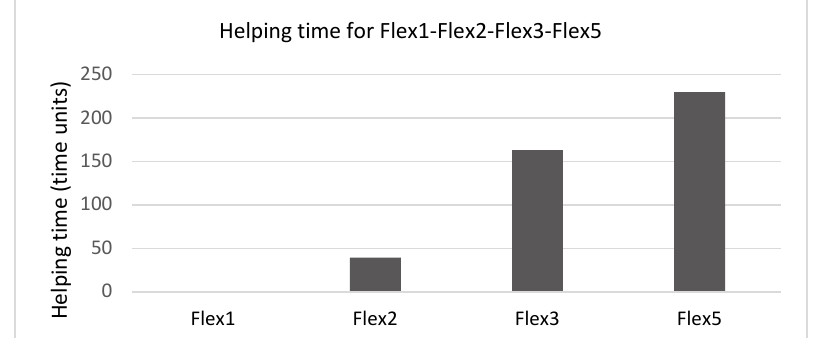
Fig. 2. Helping Time (average across all workload norms and the five workers) expressed in time units for Flex1, Flex2, Flex3 and